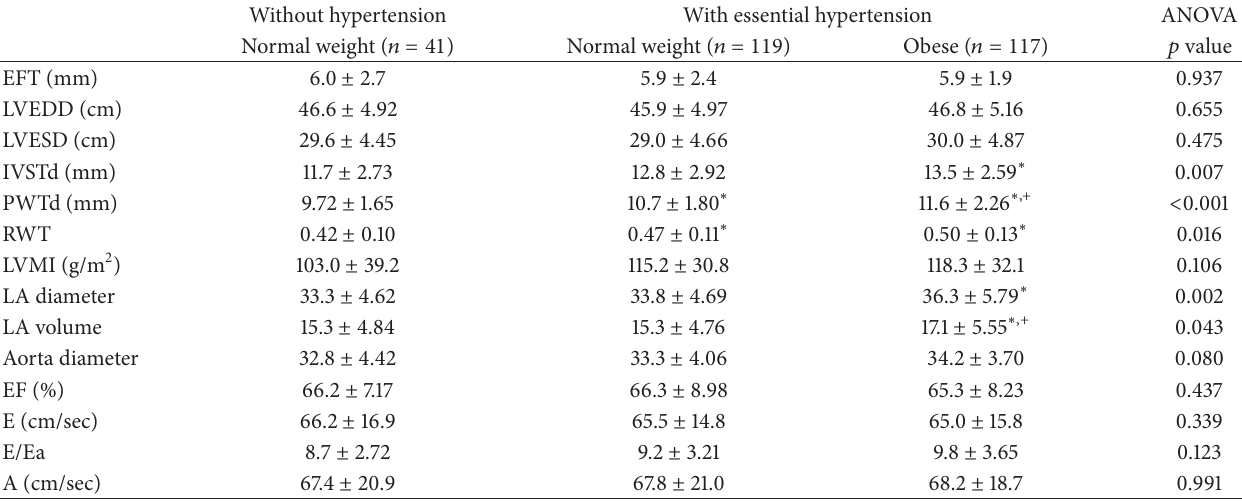
Table 3: The echocardiographic measurements of the study population in males. Without hypertension With essential hypertension ANOVA Normal weight ( 𝑛 = 41